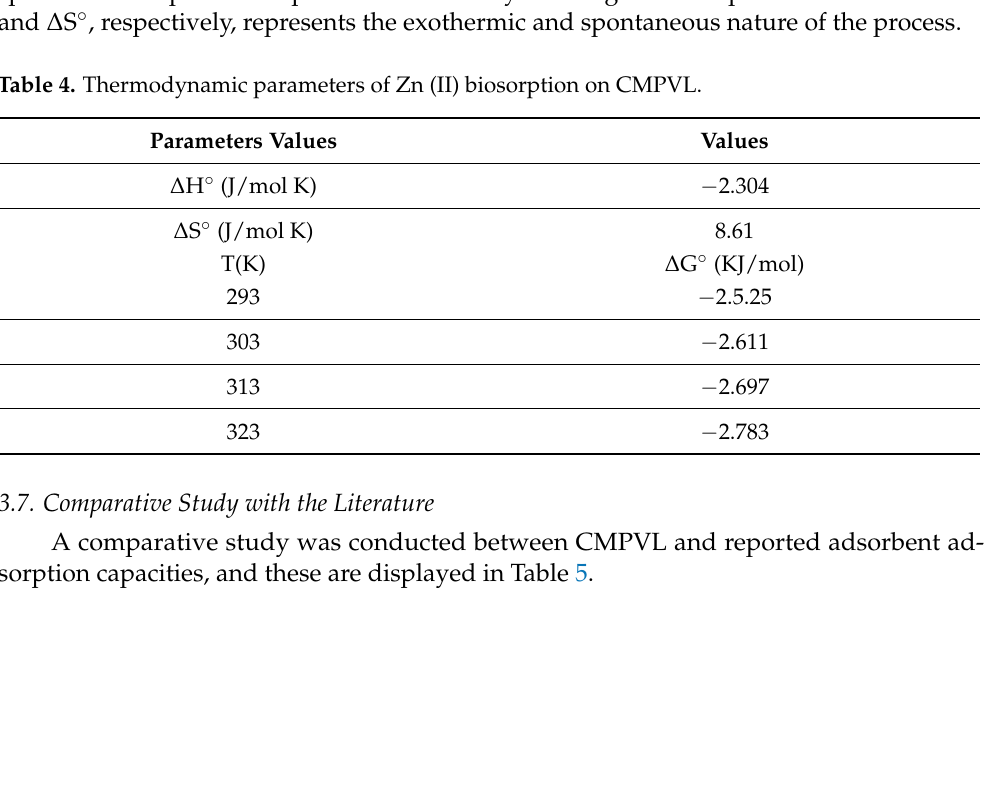
Table 4. Thermodynamic parameters of Zn (II) biosorption on